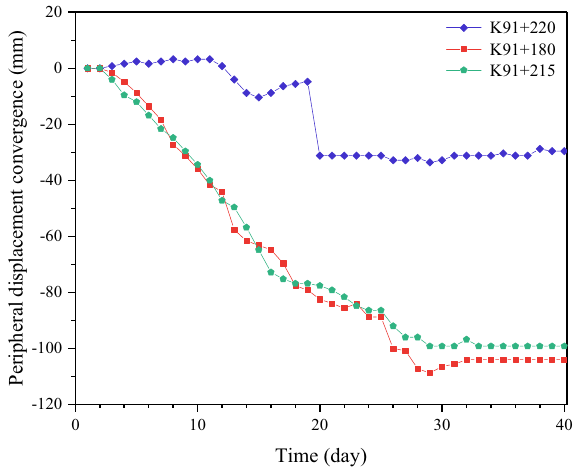
Figure 15. Curve of peripheral displacement convergence.